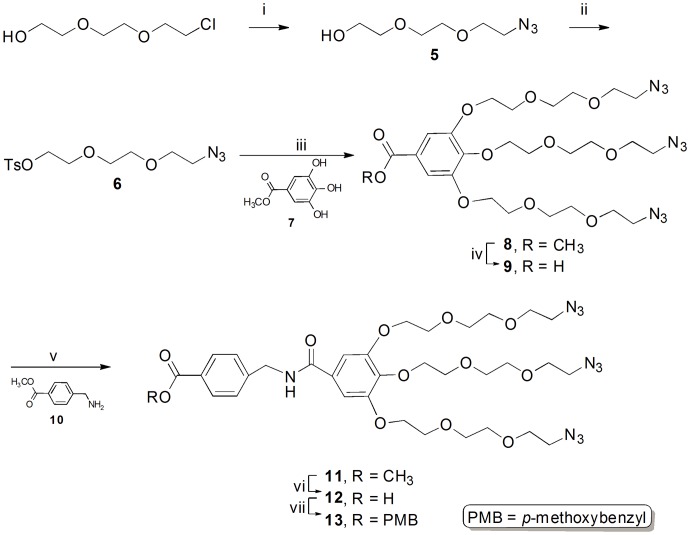
Synthesis of linker with three azido groups.(i) NaN3, DMF, 100oC, 12 h, 84%. (ii) TsCl, DMAP, TEA, DCM, rt, 12 h, 90%. (iii) K2CO3, acetone, reflux, 17 h, 94%. (iv) aq. LiOH, THF, reflux, 3 h, 95%. (v) EDAC.HCl, TEA, DCM, rt, 36 h, 60%. (vi) aq. LiOH, THF, rt, 10 h, 99%. (vii) PMB, NaHCO3, DMF, rt, 10 h, 82%.